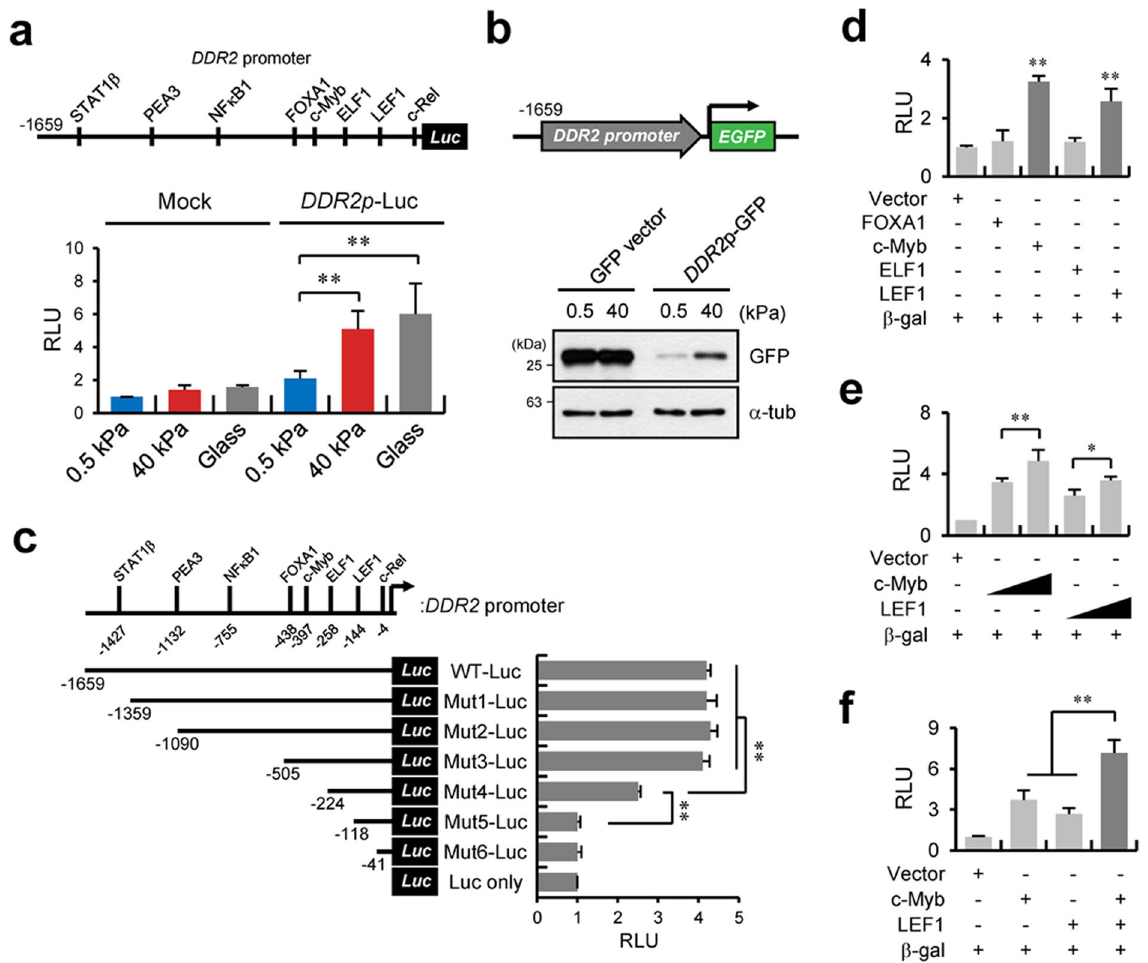
Figure 3. c-Myb and LEF1 are responsible for DDR2 promoter activity. ( a ) Schematic representation of the DDR2 promoter and possible relevant transcription factors (top). Relative expression of a mock or DDR2 wild- type (WT) promoter-driven luciferase reporter in H1299 cells incubated on a PAG with the indicated stiffness or on glass (bottom). ( b ) Western blot analysis of green fluorescent protein (GFP) under the control of the DDR2 WT promoter in H1299 cells incubated on a PAG with the indicated stiffness. ( c ) A schematic of the DDR2 WT promoter and six truncated constructs in reporter vectors (top). Relative expression of DDR2 WT or truncated promoter–driven luciferase reporters in H1299 cells incubated on a PAG with the indicated stiffness (bottom). ( d ) Relative expression of DDR2 WT promoter–driven luciferase reporters in FOXA1-, c-Myb-, ELF1-, or LEF1-overexpressing H1299 cells (bottom). ( e , f ) Relative expression of DDR2 WT promoter–driven luciferase reporters in c-Myb- or LEF1-overexpressing H1299 cells in a dose-dependent manner ( e ) and in co-overexpressing H1299 cells ( f ). Data in ( a ), ( c ), ( d ), ( e ) and ( f ) represent the mean of three independent experiments ± SEM. * P < 0.05, ** P <